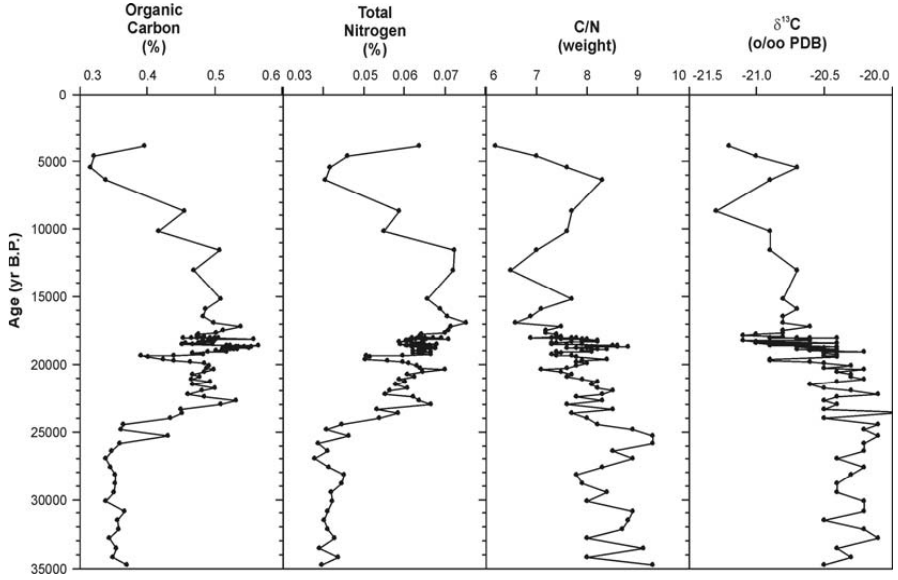
Fig. 5 – Variations in organic carbon, total nitrogen, C/N ratio and δ 13 C in core 7485. Isotope stage limits based on Martinson et al.